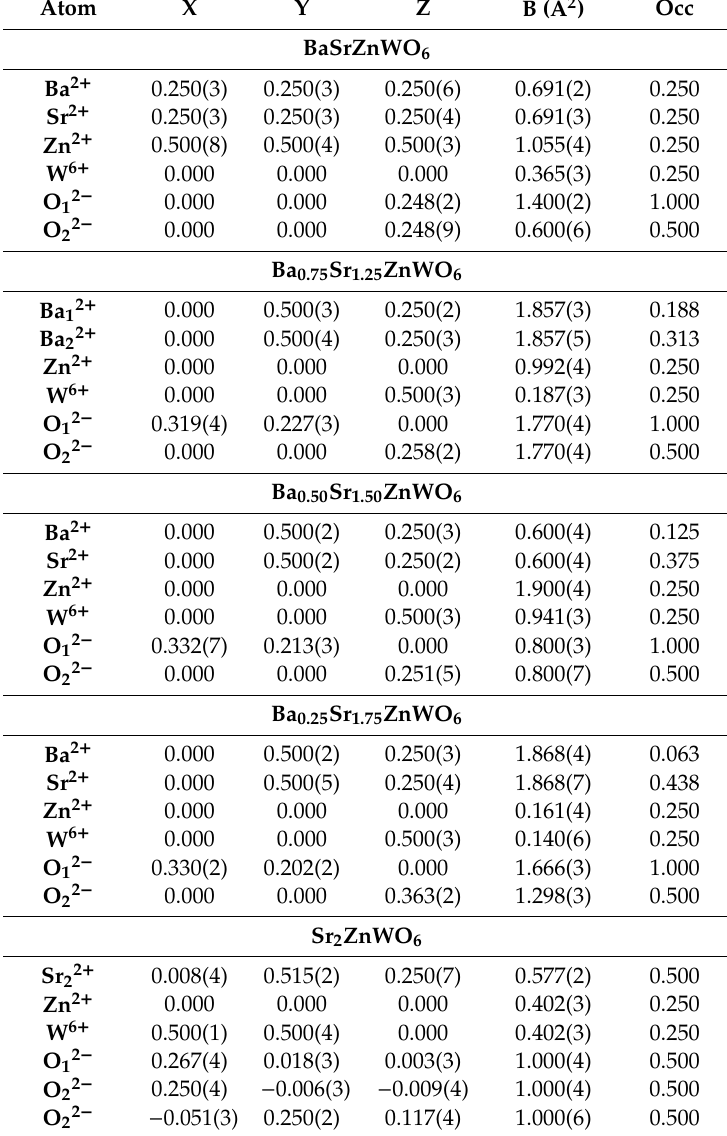
Table 2. Atom coordinates of Ba 2 − x Sr x ZnWO 6 double perovskite series (x = 1.25, 1.50, 1.75, 2) following Rietveld refinement of x-ray powder di ff